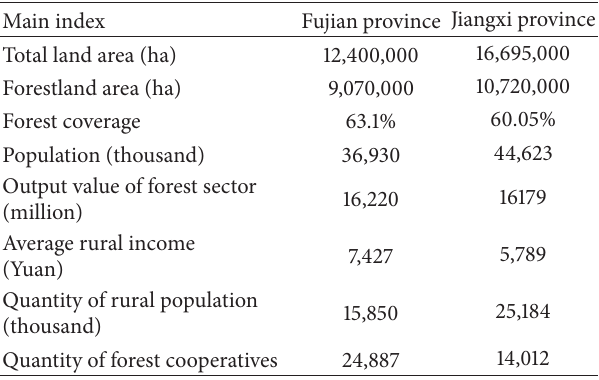
Table 1: Forest resources and socioeconomic information in Fujian and Jiangxi